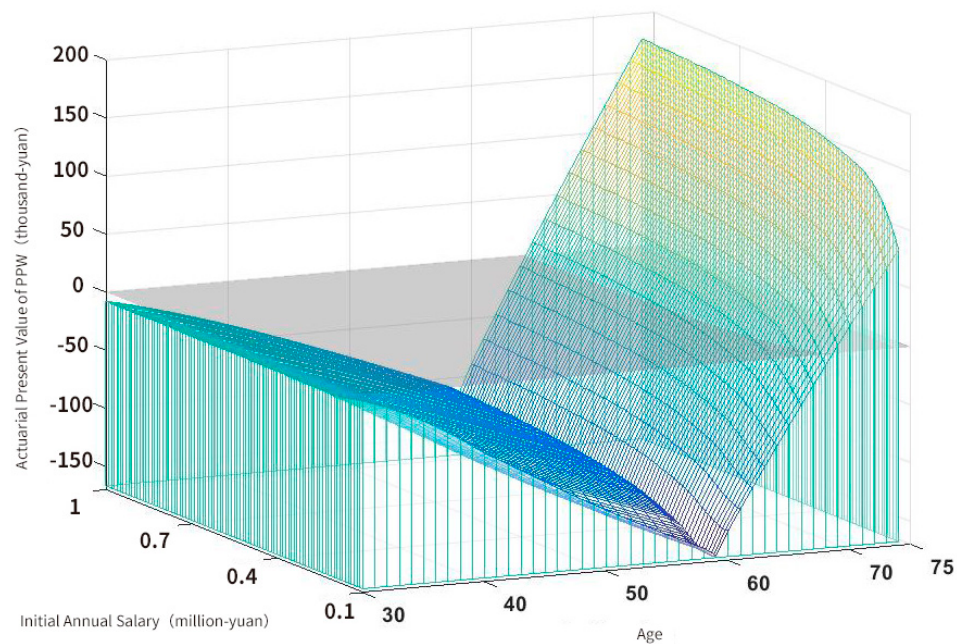
Figure 7. The impact of different initial annual salaries of 30-year-old insured men on the present value of PPW.